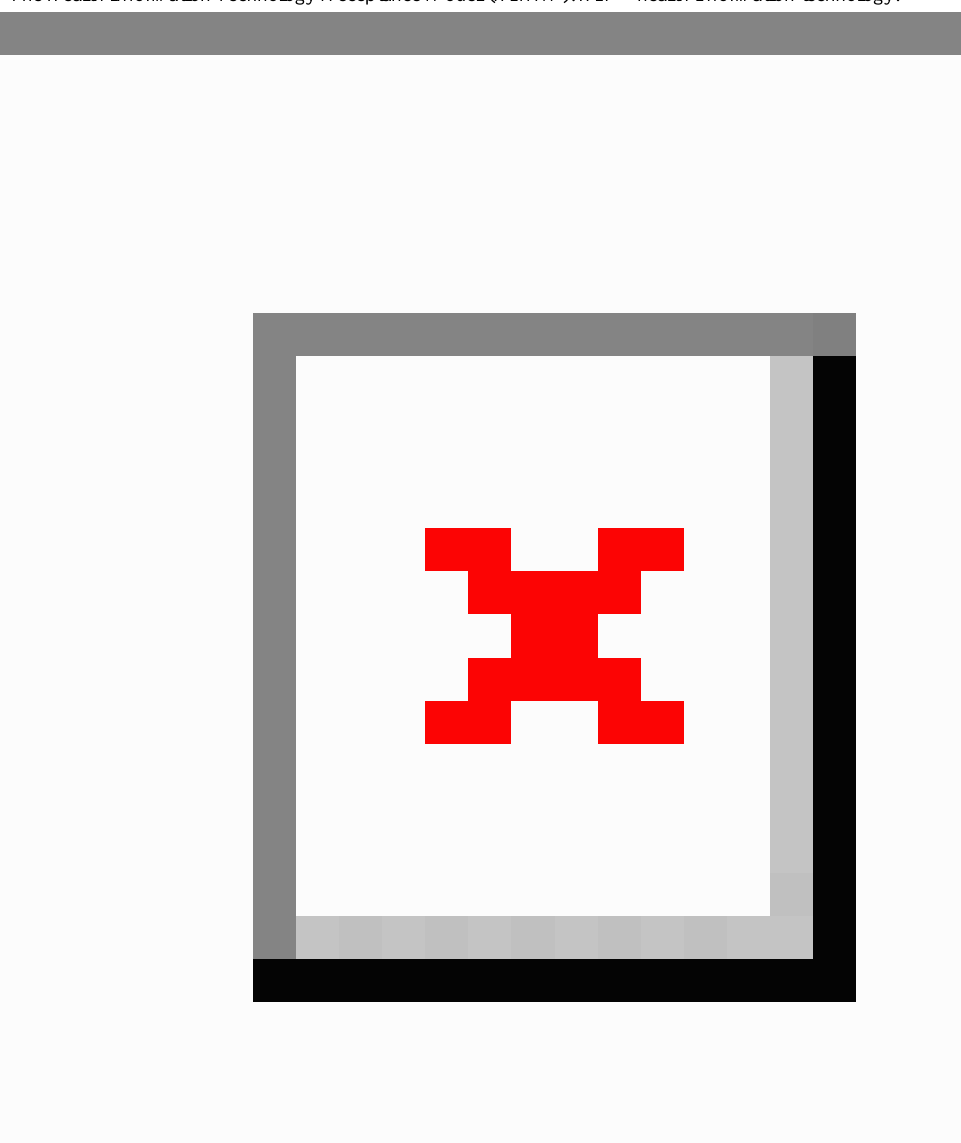
Figure 3. The Health Information Technology Acceptance Model (HITAM). HIT = health information